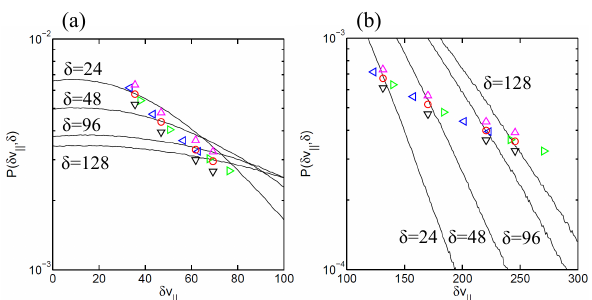
Fig. 4. Finding s(Y ) and P s (Y) in the ROMA analysis at (a) Y = 10 and (b) Y = 40. For (a) , Y = 10, P(δv || ,δ) are obtained by Eq. (7) at δ = ( 24 , 48 , 96 , 128 )1 using five sets of values of ( s , P s ) : red circles for s =0.399, P s = 2 . 0510 − 2 ; green right-triangles for s =0.419, P s = 2 . 0510 − 2 ; blue left-triangles for s =0.379, P s = 2 . 0510 − 2 ; magenta up-triangles for s =0.399, P s = 2 . 2510 − 2 ; black down-triangles: s =0.399, P s = 1 . 8510 − 2 . Solid black curves are from JHU data with δ = ( 24 , 48 , 96 , 128 )1 . The pair ( s , P s ) = ( 0 . 399 , 2 . 0510 − 2 ) gives P(δv || ,δ) , shown in red circles, consistent with the JHU data and is chosen to be the solution for Y = 10. Sim- ilarly for (b) at Y = 40: red circles: ( s , P s ) = ( 0 . 374 , 2 . 210 − 3 ) ; green right triangles: (0.394, 2.2 10 − 3 ) ; blue left triangles: (0.354, 2.2 10 − 3 ) ; magenta up triangles: (0.374, 2.4 10 − 3 ) ; black down triangles: (0.374, 2.0 10 − 3 ) . The pair ( s , P s ) = ( 0 . 374 , 2 . 210 − 3 ) is chosen as the solution at Y =